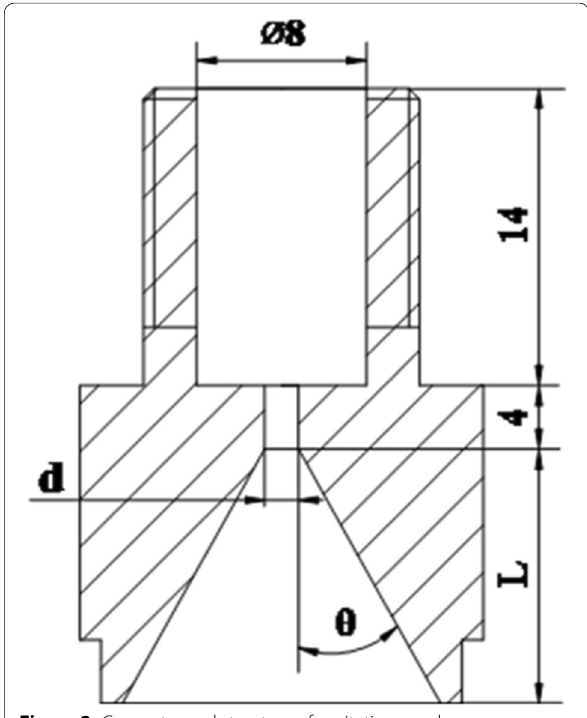
Figure 2 Geometry and structure of cavitation